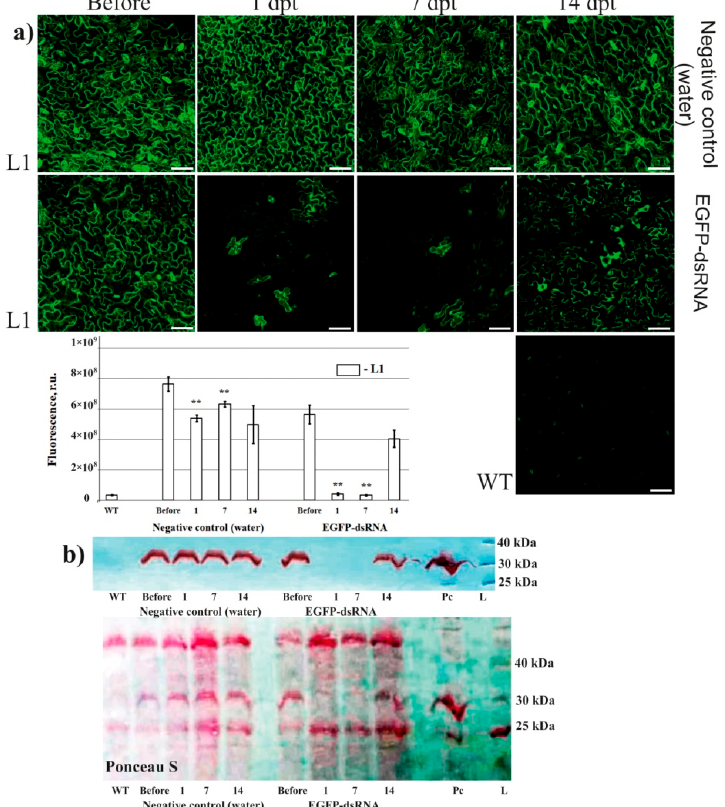
Figure 4. The effect of external dsRNA application on the EGFP fluorescence and EGFP protein levels in four-week-old Arabidopsis plants of the L1 line. EGFP silencing efficiency was visualized 1, 7, and 14 days post-treatment of L1 rosettes using confocal microscopy ( a ) and western blotting ( b ). Pc – total protein purified from E. coli Rosetta(DE3)pLysS transformed with pET28a-EGFP. Values are the mean ± SE. ** ‒ significantly different from the negative control at P ≤ 0.01, respectively, according to the Student’s t -test.